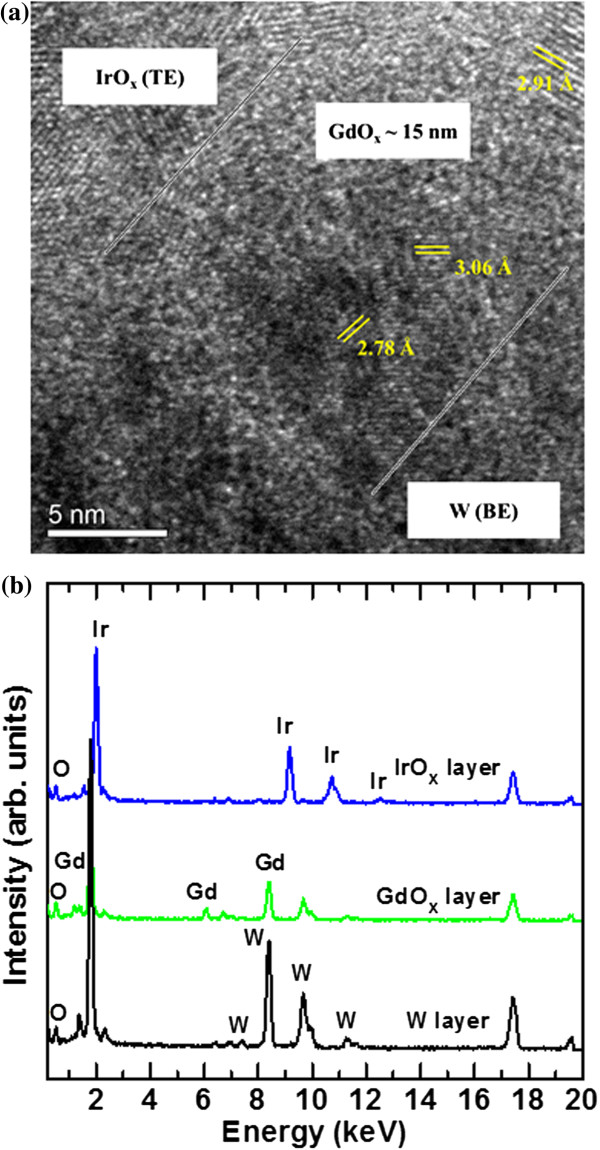
TEM image and EDX spectra. (a) Cross-sectional TEM image of IrOx/GdOx/W structure. Polycrystalline GdOx film is observed. (b) EDX spectra show the Ir, Gd, W, and O elements.